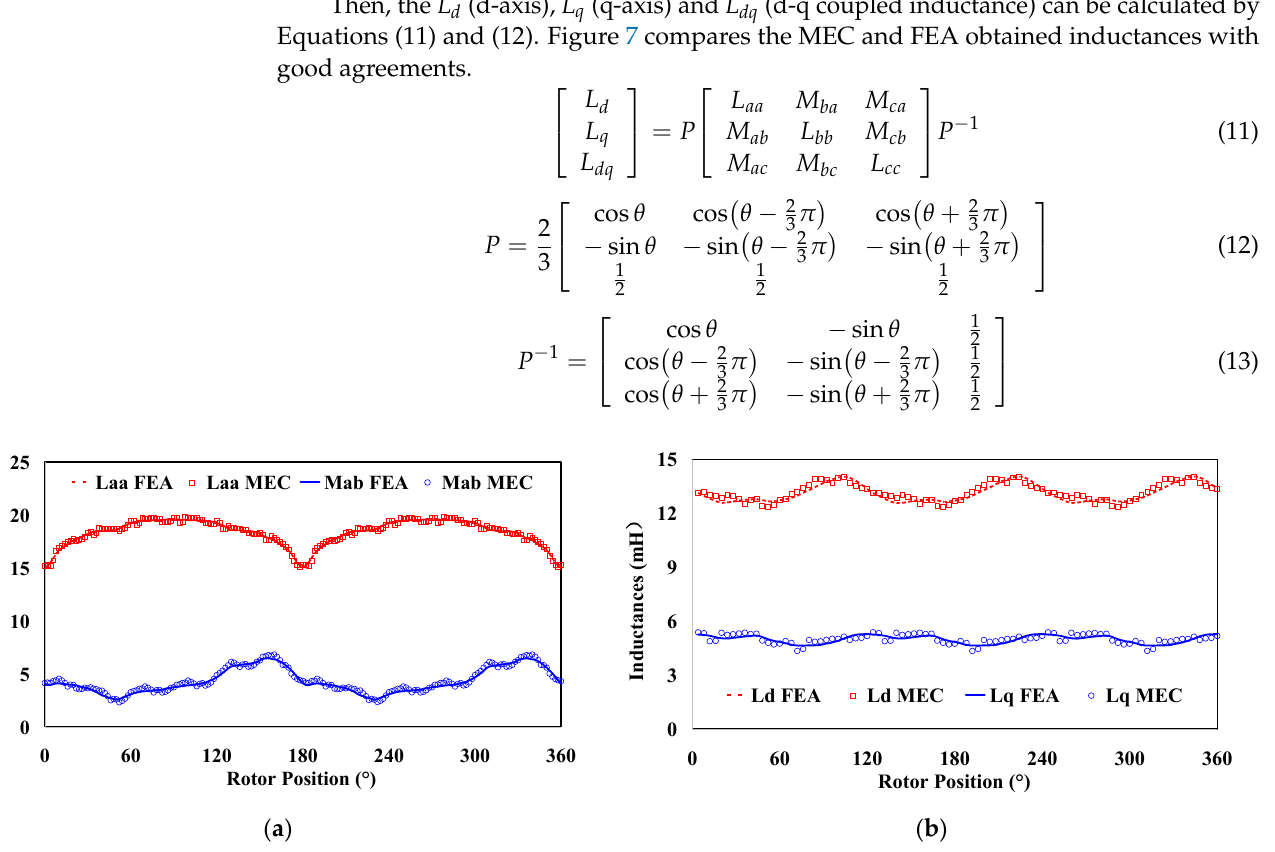
Figure 8. Torque vs. rotor positions when 30 A is applied.